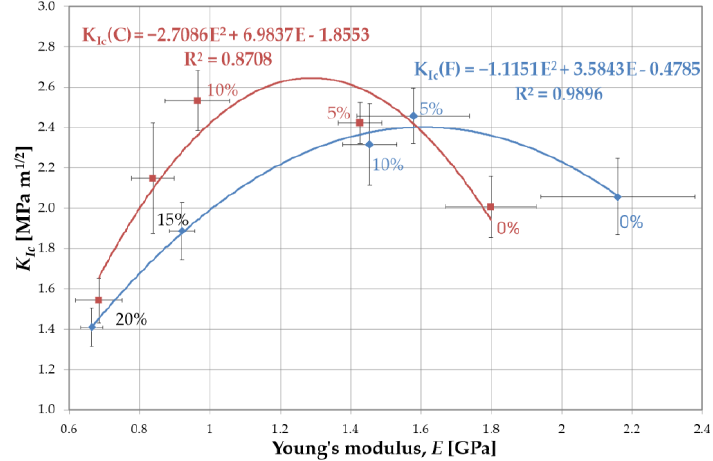
Figure 10. Optimization of the concentration of rubber in resins based on the analysis of fracture toughness and Young’s modulus.